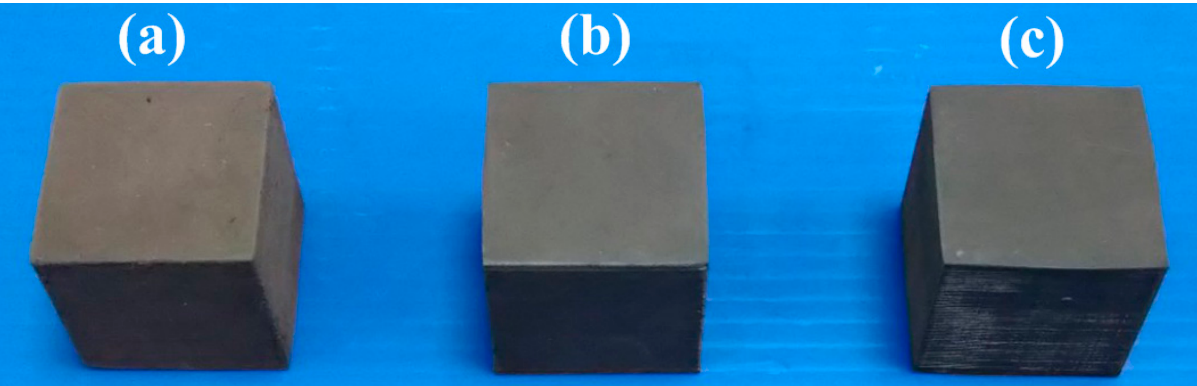
Figure 6. Top view of the specimens made with recipes ( a ) 3, ( b ) 5, ( c ) 7, and ( d ) 9.